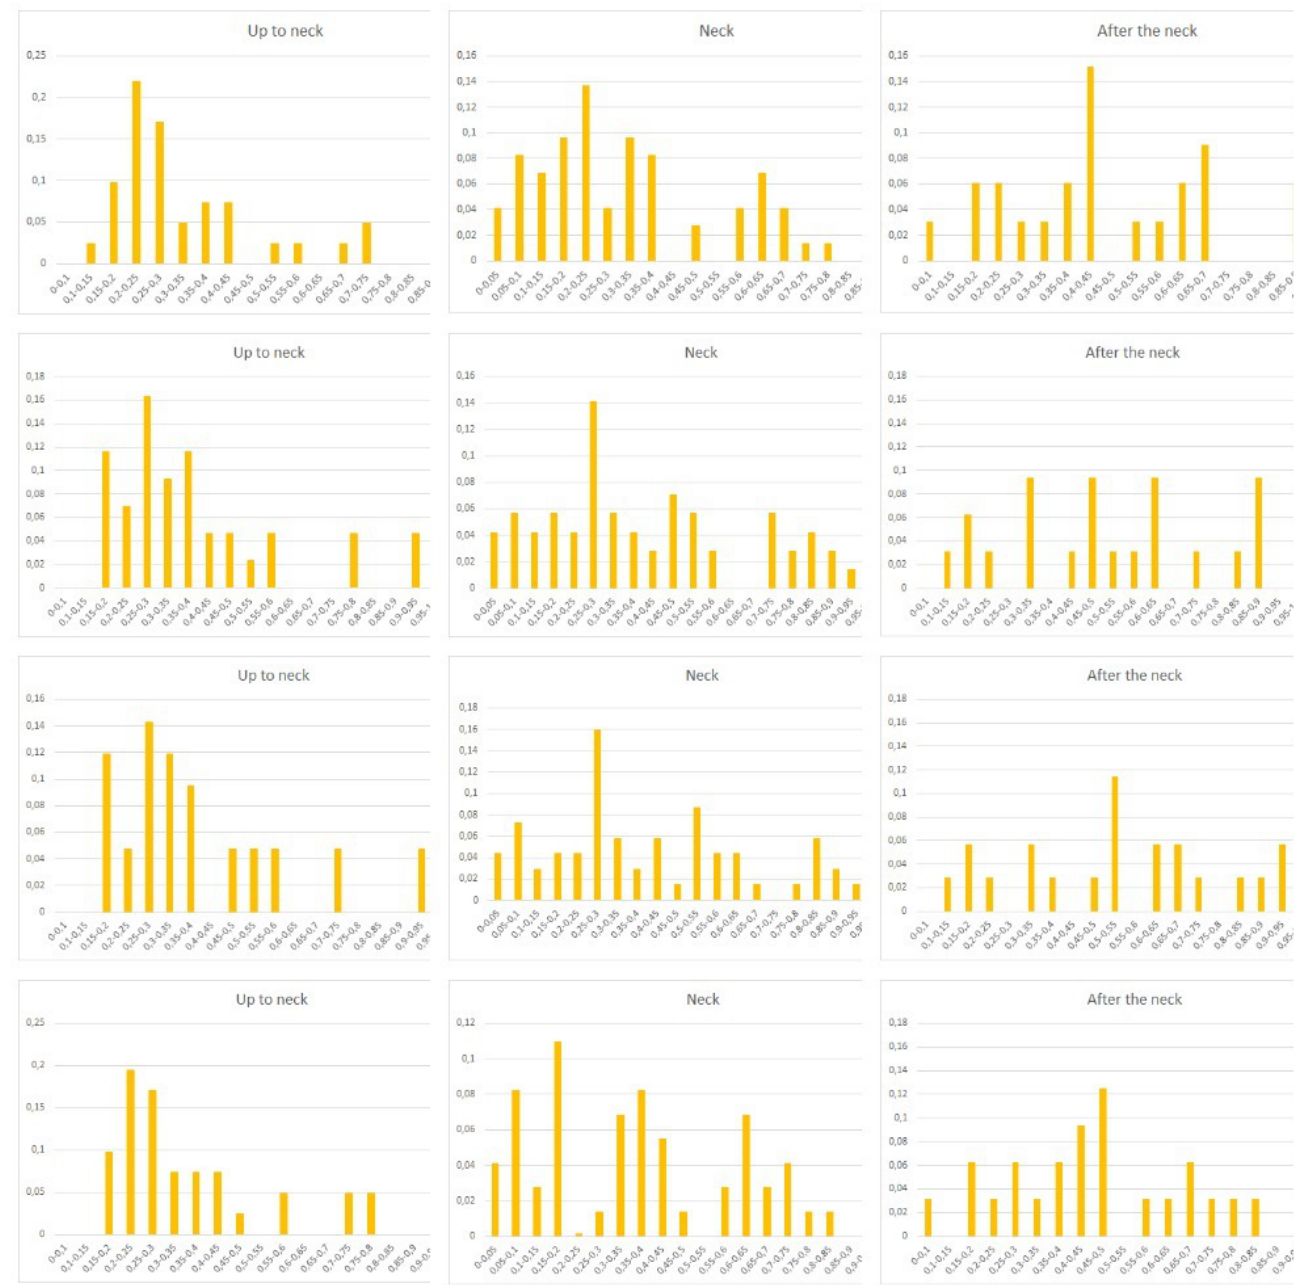
Figure A4. Histograms of ∆ WSS distribution over the stent surface of Patient 4. This section presents histograms of the ∆ WSS distribution over the stent surface in all patients at all time